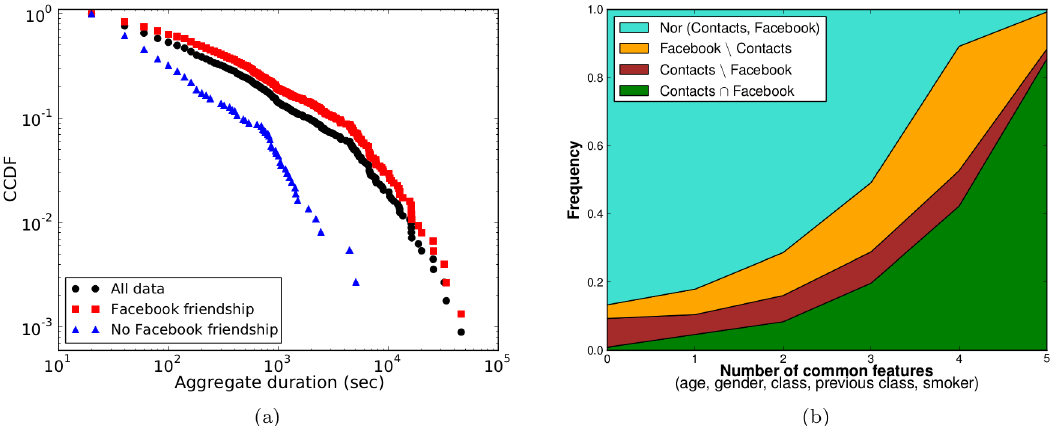
Fig 8. Contact vs. Facebook links. a) Distribution of aggregate durations for the different sets of links. b) Fractions of pairs of students belonging to specific groups (no link, link in both the contact network and Facebook, link in only one of the two) as a function of the number of common